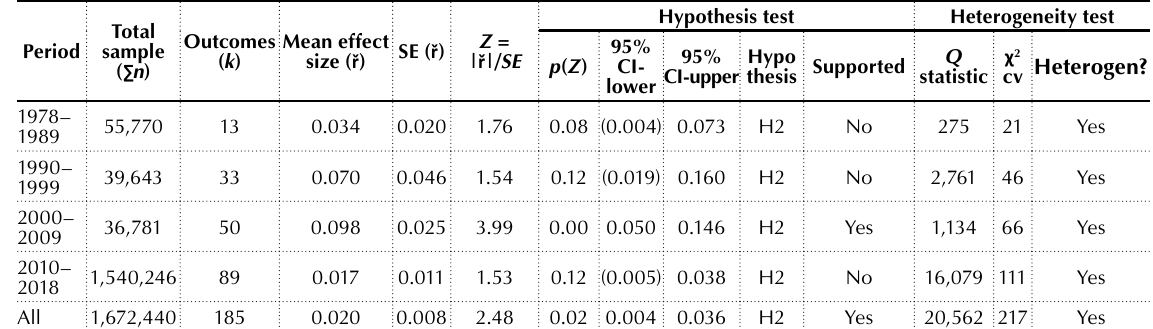
Table 6. Hypothesis testing – meta-analysis – tax rate